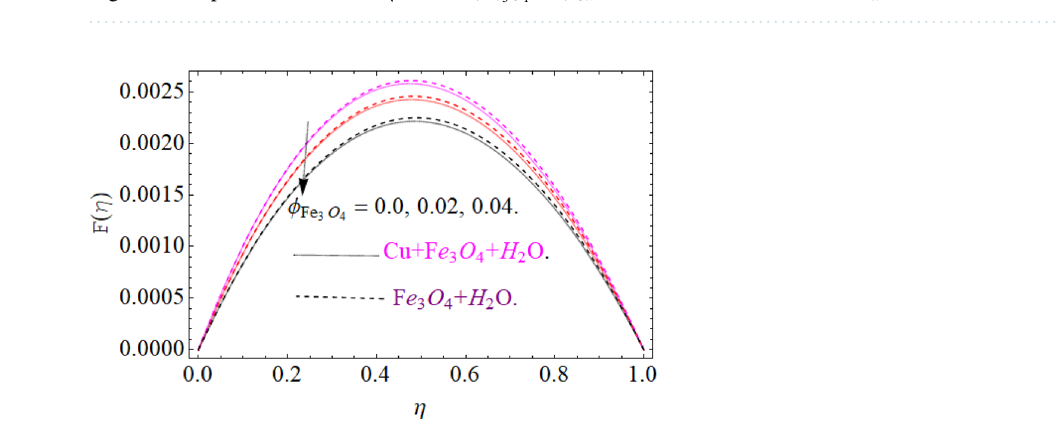
Figure 2. Impression of M on F( η ), When φ Fe 3 O 4 = φ Cu = 0.02, Ec = 0.1, Pr = 6.2, Re ω = 0.3, Re � = 0.13 .